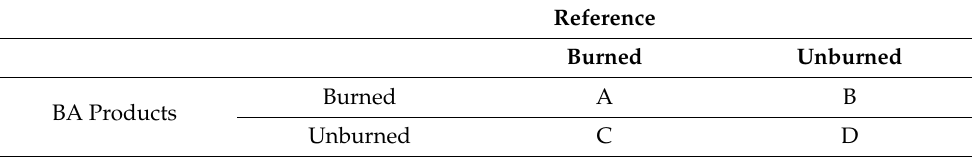
Table 4. Generic contingency table between the reference and burned area (BA) products.